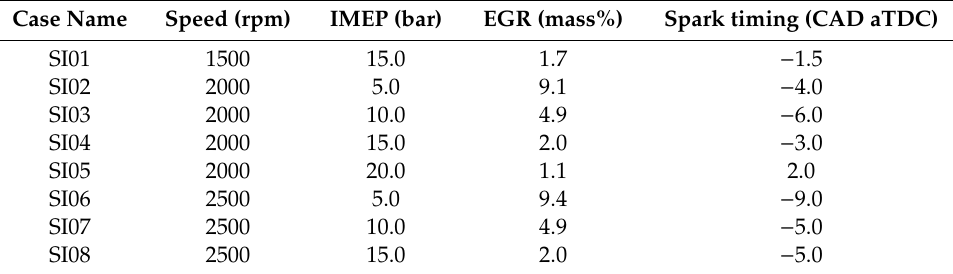
Table 6. Spark-ignition engine operating